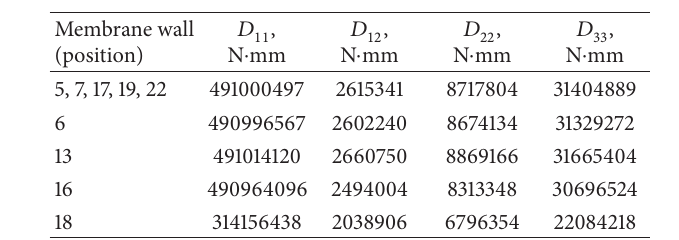
Table5:Membersofelasticitymatrixofequivalentorthotropicplate for membrane walls of “Milano” boiler for bending stiffness.